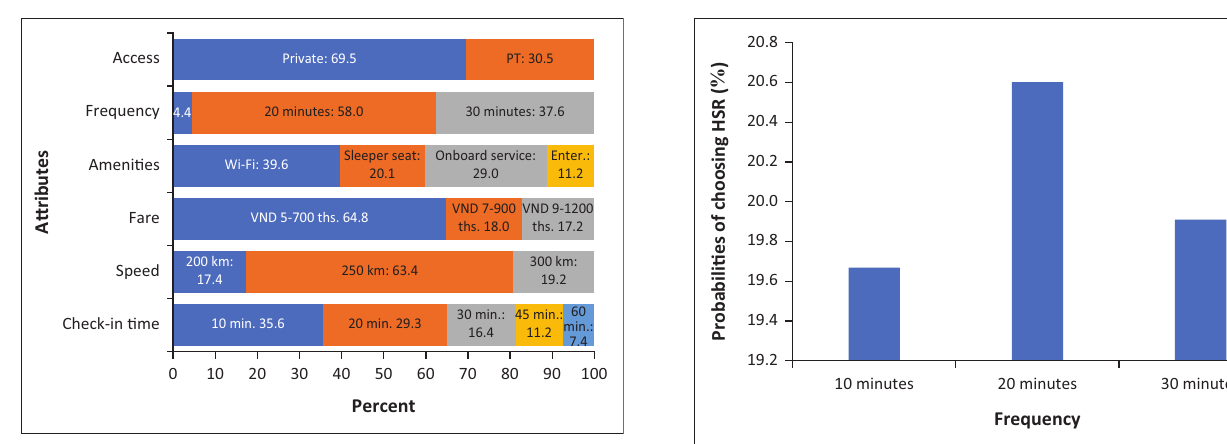
FIGURE 4: Distribution of preferences for